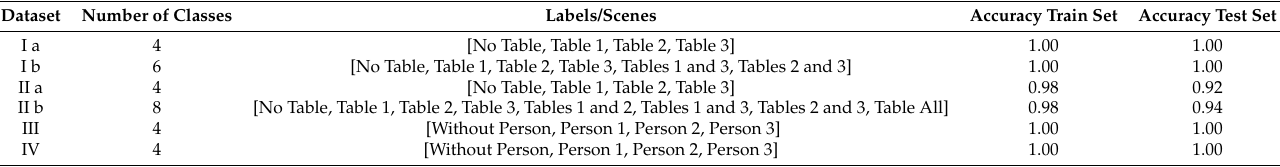
Table 3. Accuracy scores of the kNN classification for the different datasets and use